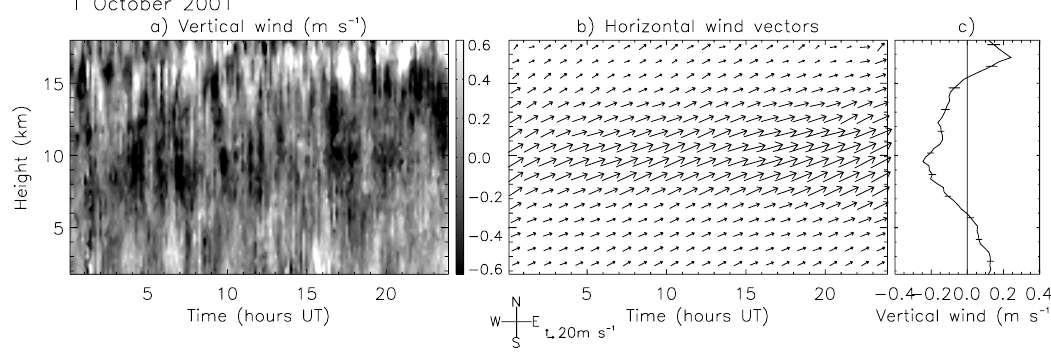
Fig. 4. Height-time plots of (a) vertical wind and (b) horizontal wind vectors, measured by VHF radar, 52.4 ◦ N, 4.0 ◦ W; (c) time average of (a), 00:00–24:00 UT.